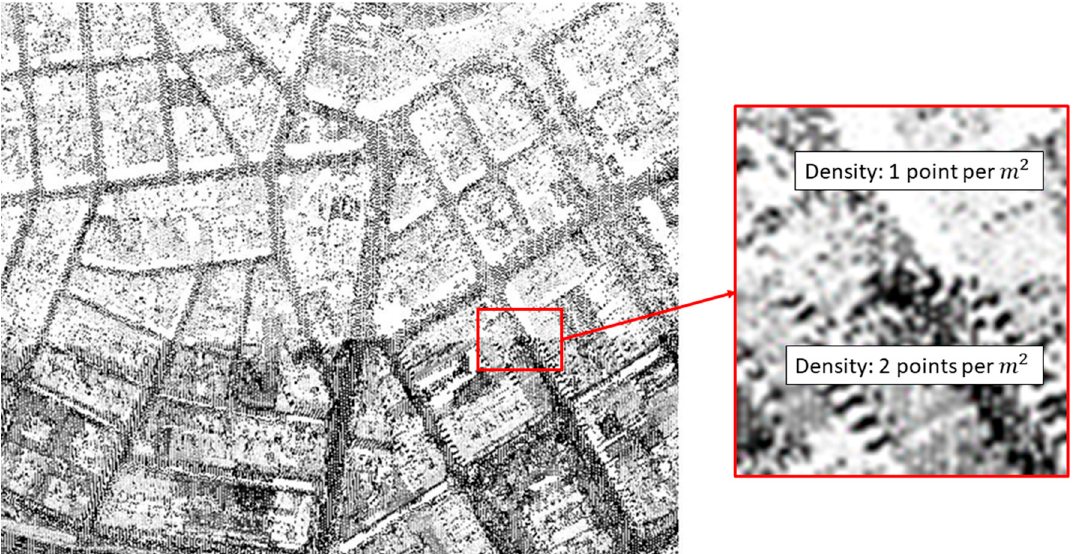
Figure 2. Visual aspect of a LiDAR point cloud using the intensity level to generate the image in grayscale. In the darkest areas, a greater density of points can be seen.